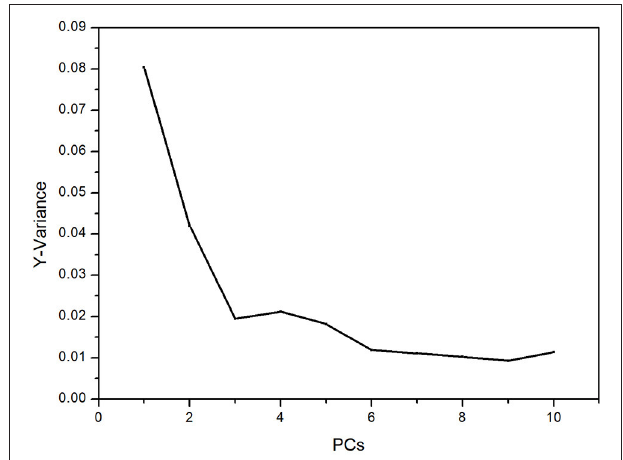
FIGURE 4 | PLS-DA Y-variance plot in the 3,100–2,800 and 1,750–900 cm − 1 spectral